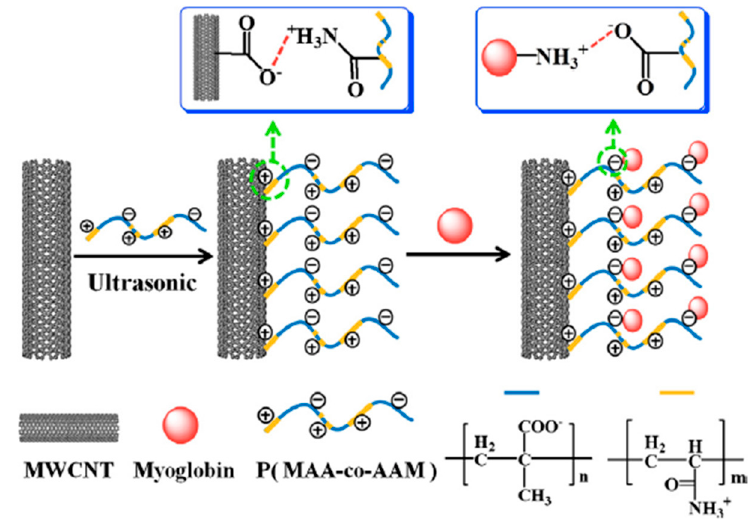
Figure 10. Fabrication process for the preparation of Mb-P(MAA- co -AAM)-MWCNT nanocomposites